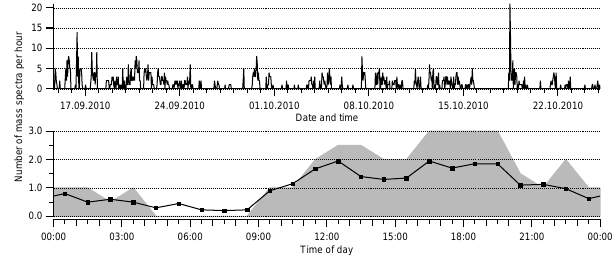
Figure 5. Time series (top) and diurnal variations (bottom, LT) of the particle type “diesel exhaust” during HCCT-2010. Markers de- note the mean values, the grey shaded area represents the upper quartile.